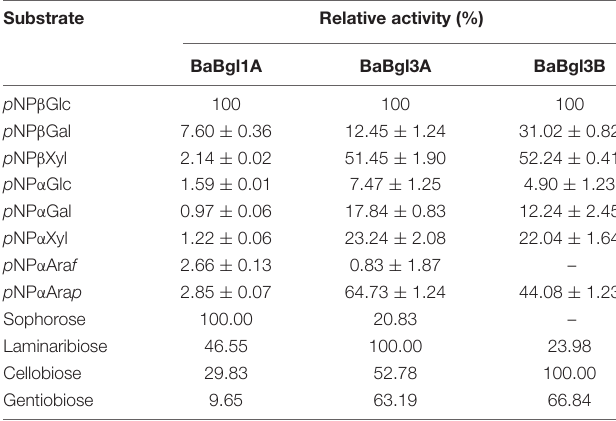
TABLE 3 | Relative activity of β -glucosidases on different aryl-glycosides and disaccharides.